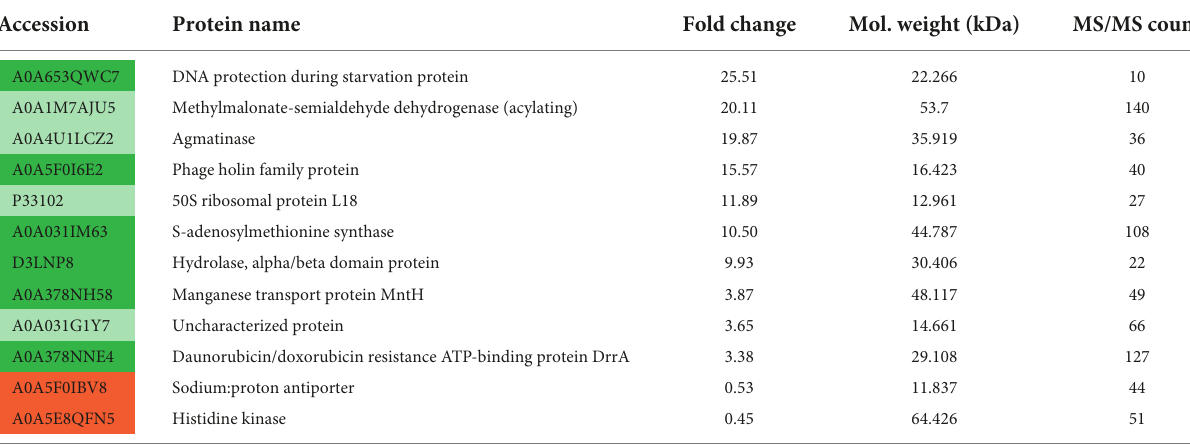
TABLE 3 Changes in M. luteus C01 biofilm matrix protein concentrations in the presence of 4.9 × 10 − 9 M epinephrine after 72 h of incubation in comparison with